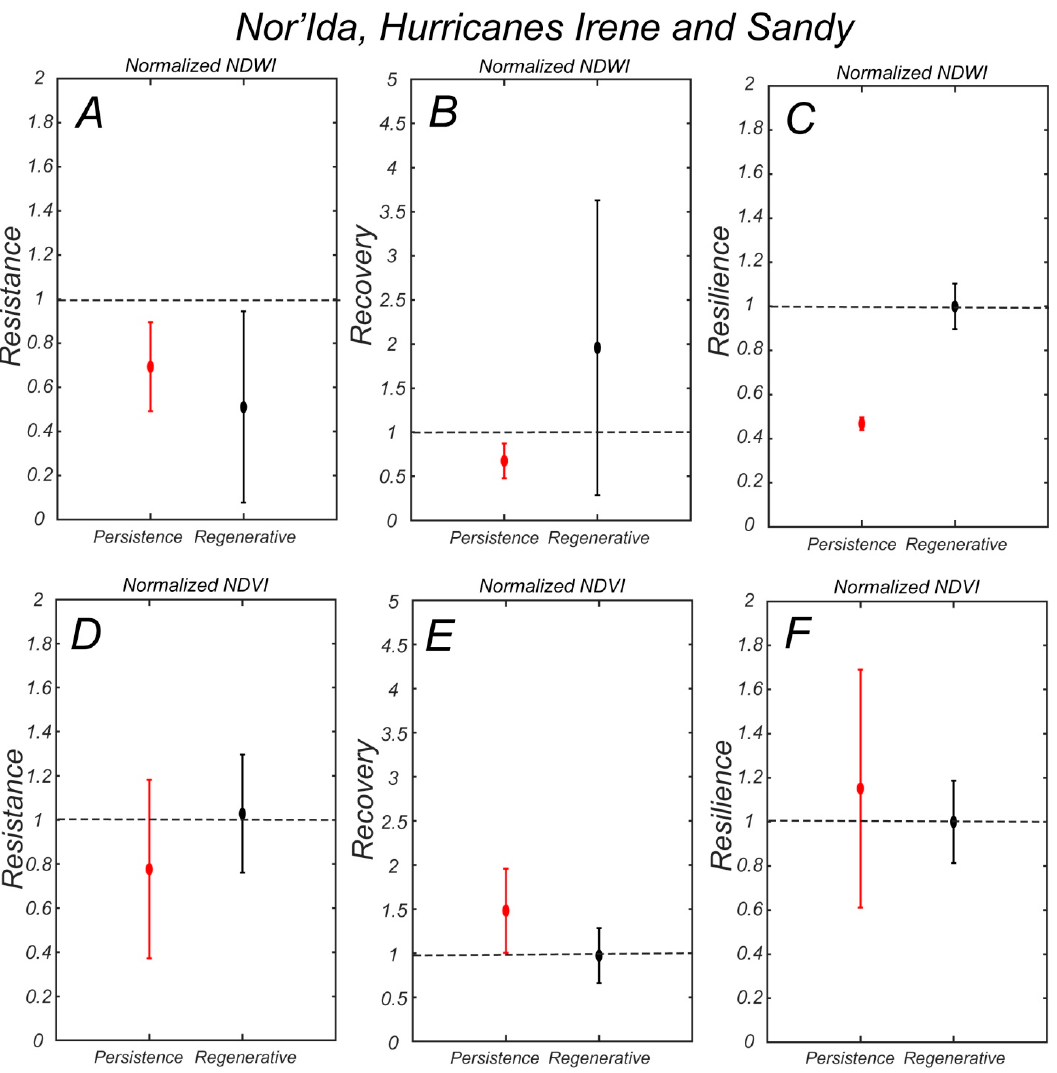
Figure 11 . ( A ) Resistance, ( B ) recovery, and ( C ) resilience of persistence and regenerative zones computed with NDWI for the combination of Nor’easter of 2009, Hurricane Irene in 2011, and Hurricane Sandy in 2012. ( D ) Resistance, ( E ) recovery, and ( F ) resilience computed with NDWI.